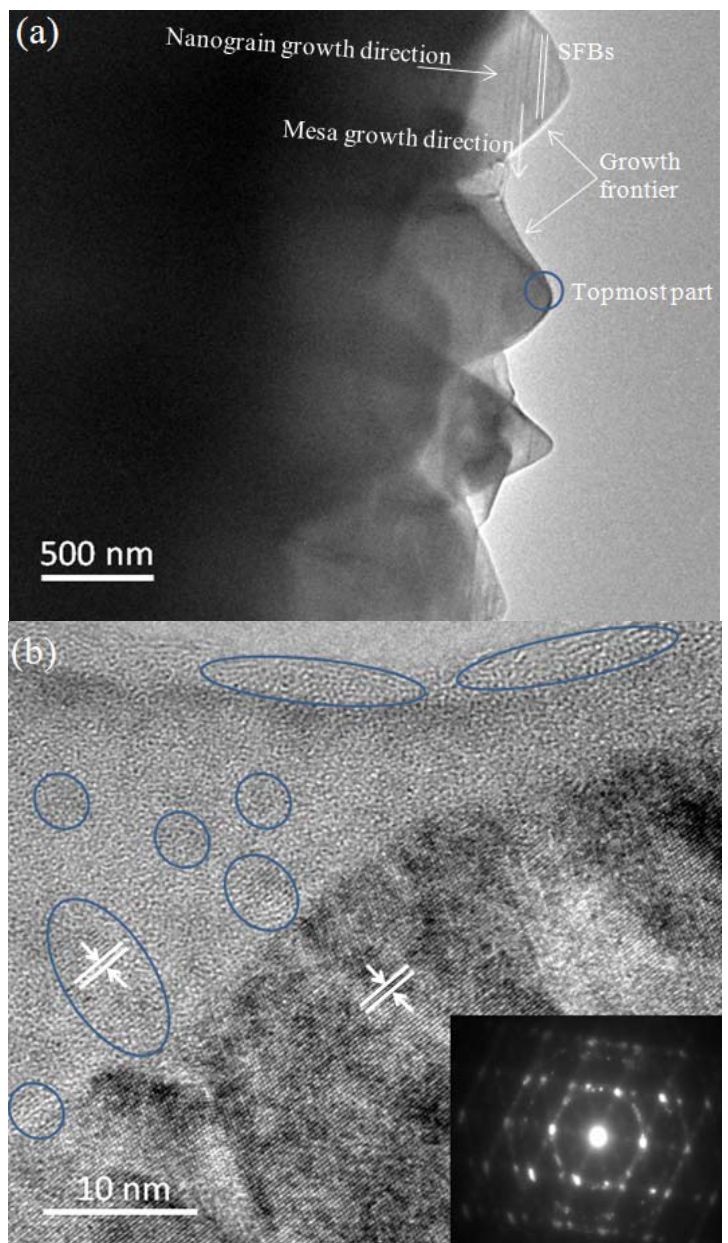
Figure 4. (a) TEM image of SiC films in cross section near the growth frontier; (b) HRTEM image of the topmost part of an individual SiC nanograin (blue circle in (a)) and its corresponding selective area electric diffractions (SAED) pattern. The blue ellipses indicate nanosized multilayer